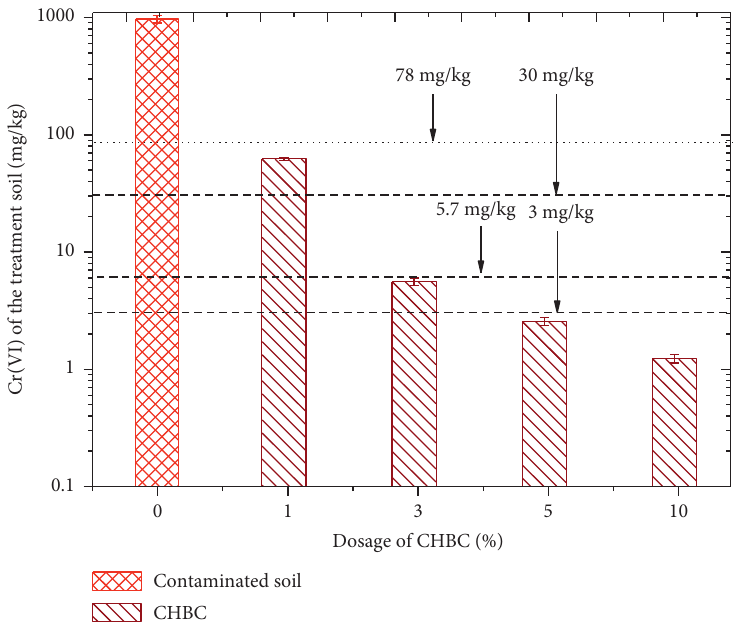
Figure 4: Effect of CHBC dosage on Cr(VI) content of stabilized